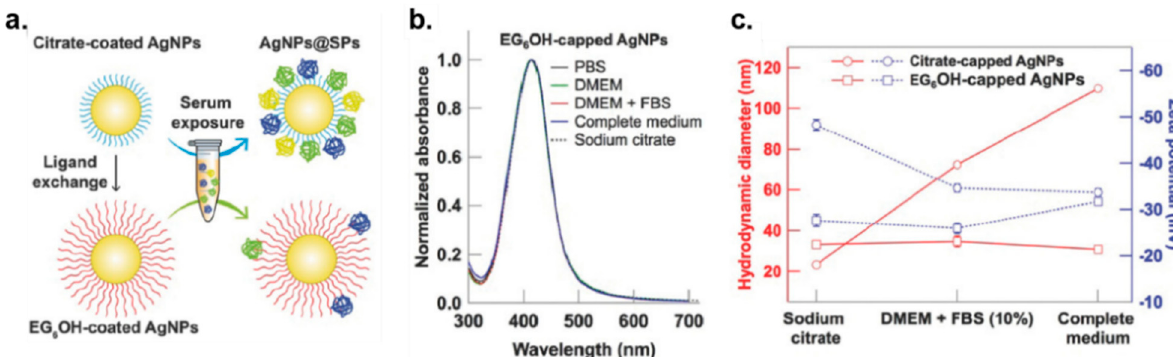
Figure 2. ( a ) Schematic illustration of serum protein adsorption on the surface of citrate-coated AgNPs and the formation of nonfouling AgNPs by coating OEG groups. ( b ) The stability of OEG-functionalized AgNPs was confirmed by measuring UV-vis absorption spectra in various culture medium. ( c ) Hydrodynamic diameter and zeta potential of AgNPs before and after incubation in growth media. (Adapted with permission from Reference [60]; Published by WILEY, 2018).